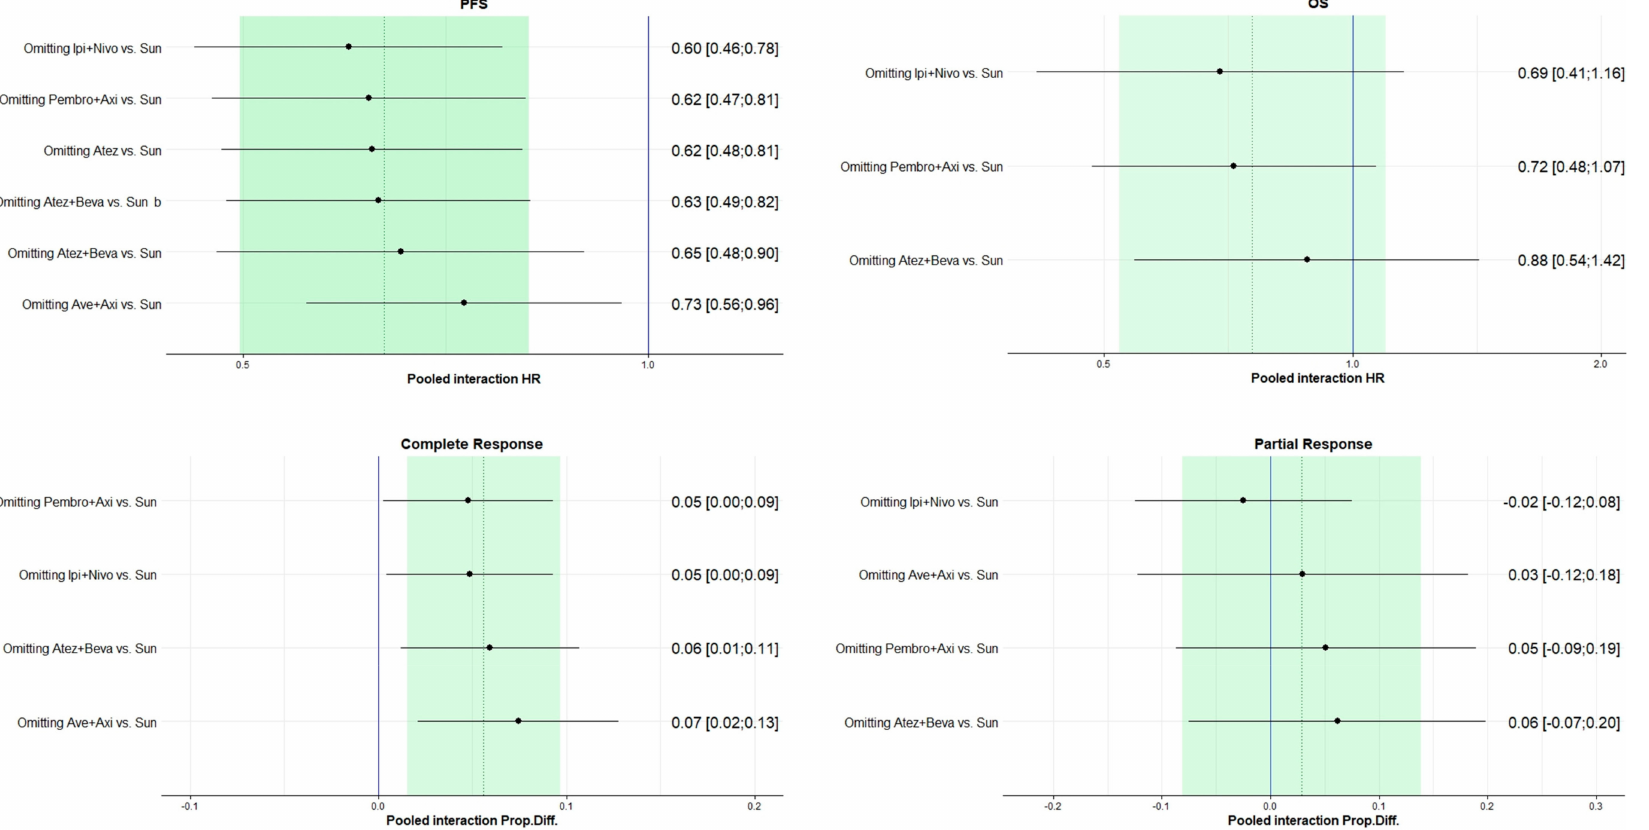
Figure 7. Leave-One-Out-Analyses. Pooled interaction estimates sorted by e ff ect